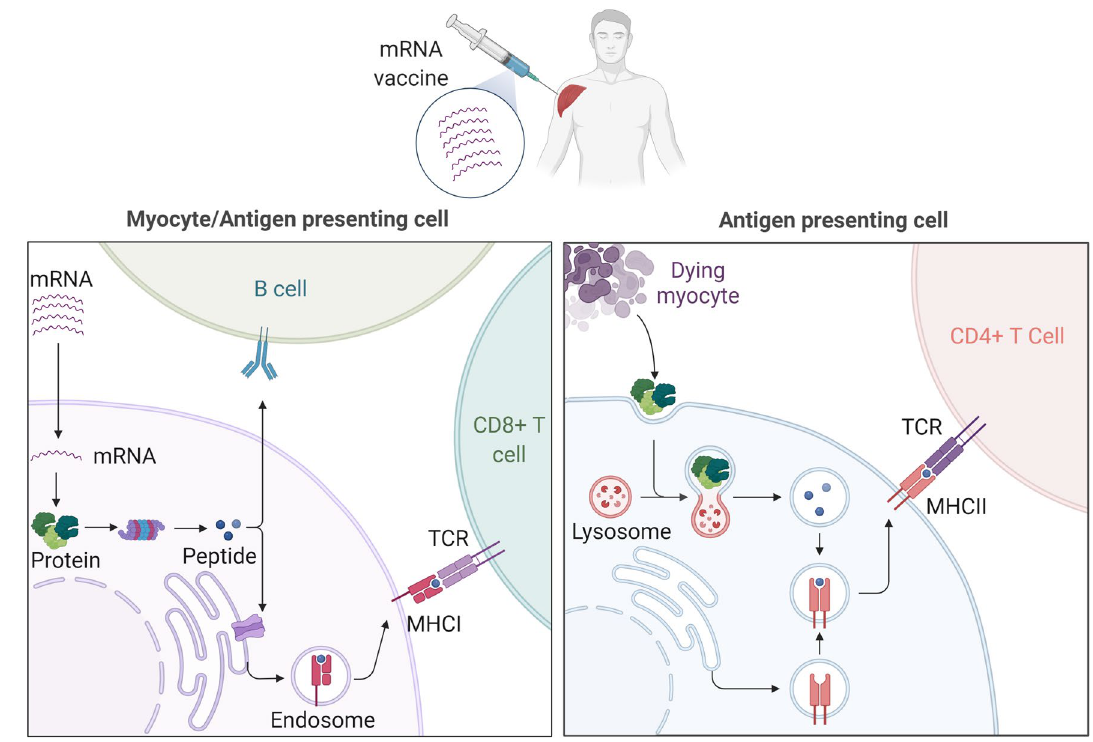
Fig. 3 mRNA vaccine. mRNA vaccines work by inducing cells to produce antigens. Once inside the cells, mRNA is translated into proteins, which are processed into antigenic peptides presented on MHC molecules. Antigen presenting cells can also take up proteins released by dying cells to process and present them on MHC molecules. B cells and T cells that can recognize antigenic peptides and peptide:MHC com- plexes, respectively, are activated to initiate an adaptive immune